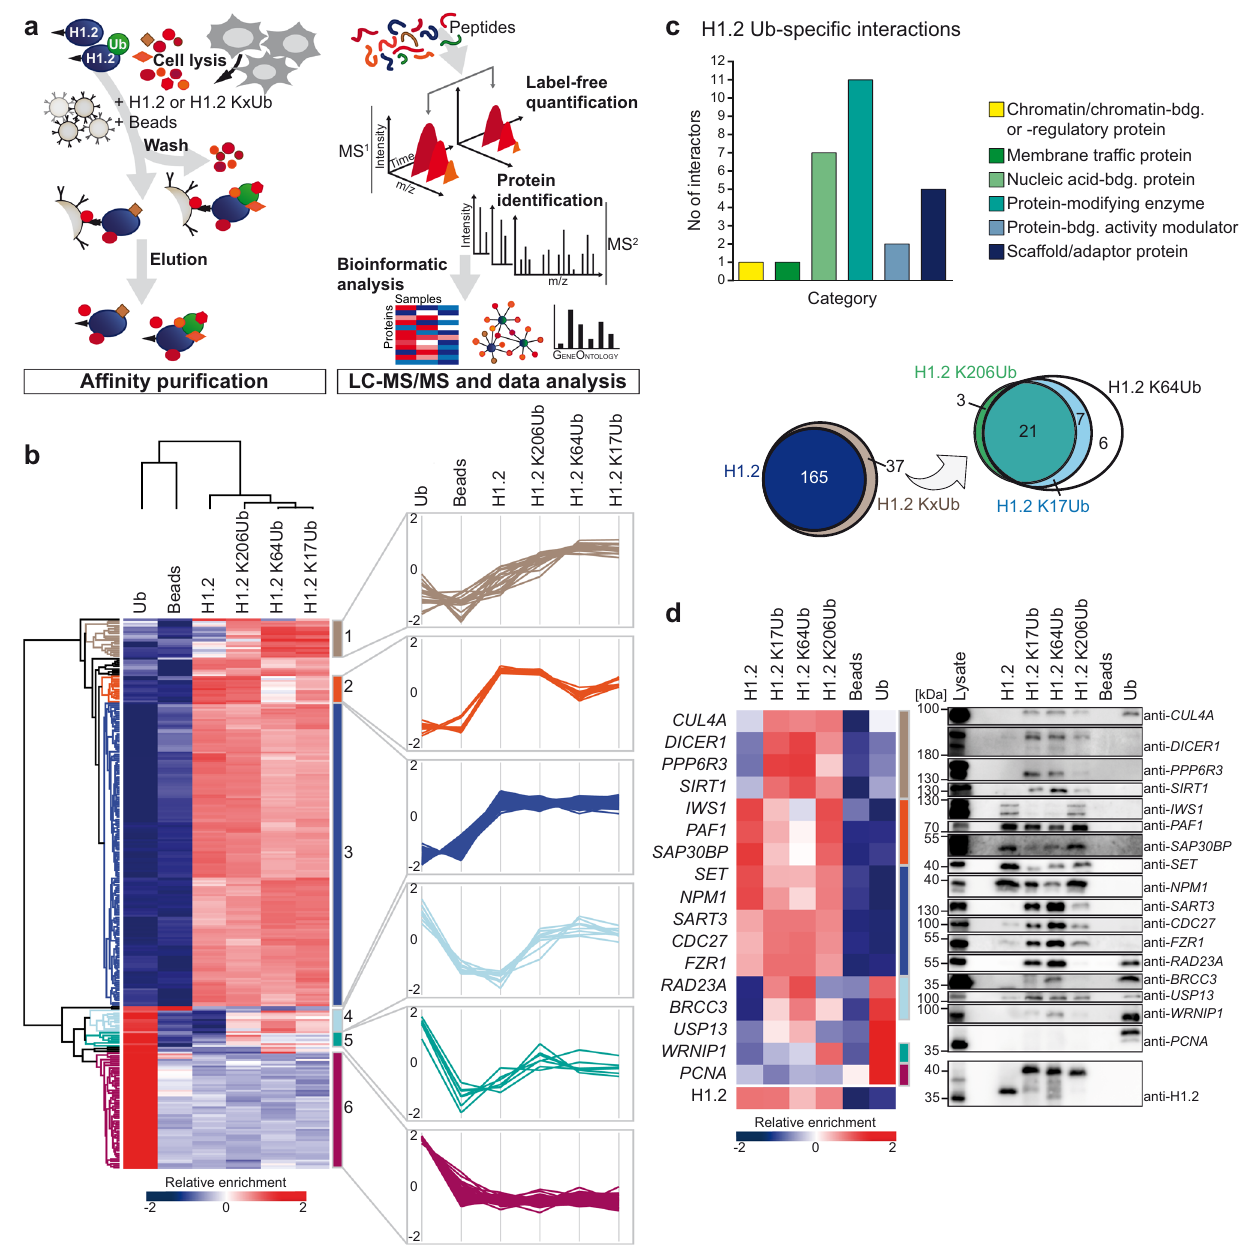
Fig. 2 Identi fi cation of the ubiquitylation-dependent modular H1.2 KxUb interactome. a Schematic overview of the AP-MS-based work fl ow to identify interactors of H1.2 KxUb variants. b Hierarchical clustering of statistically signi fi cant interactors following ANOVA analysis (FDR = 0.001, S0 = 2, n = 3). Interacting proteins are shown in rows, columns represent bait proteins used in AP-MS experiments. AP-MS experiments were carried out in biological triplicates in HEK 293T whole cell lysates. Empty beads (no bait protein) and beads decorated with free Ub were added as controls. Clusters of proteins with similar interaction behavior are depicted in different colors (left). Pro fi le plots of clusters with speci fi c binding patterns are shown on the right. c Venn diagrams (bottom) of all proteins that speci fi cally interact with unmodi fi ed H1.2 or H1.2 KxUbs, respectively (left) and all H1.2 KxUb-speci fi c interacting proteins with site-speci fi c resolution (right), not including interactors of free Ub (for those see cluster 6). Further GO-term analysis of all ubiquitylation- speci fi c H1.2 KxUb-interacting proteins based on PANTHER classi fi cation (top). d Heatmap showing the relative enrichment of selected proteins as identi fi ed by AP-MS (left) and by immunoblotting (right). Lysate and elution fractions of the af fi nity puri fi cation assay were subjected to western blot analysis with antibodies speci fi c for the indicated